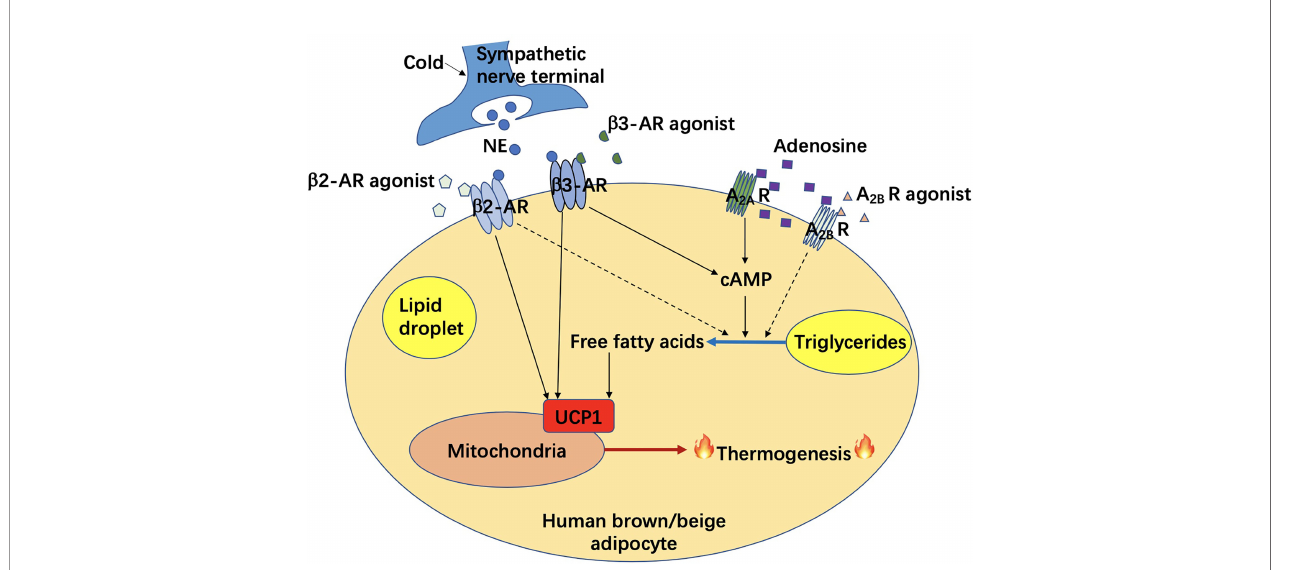
FIGURE 1 | Adrenergic receptor and adenosine receptor mediated non-shivering thermogenesis in human brown/beige adipocytes. AR, adrenergic receptor; A 2A R, adenosine A 2A receptor; A 2B R, adenosine A 2B receptor; cAMP, cyclic adenosine monophosphate; NE, norepinephrine; UCP1, uncoupling protein